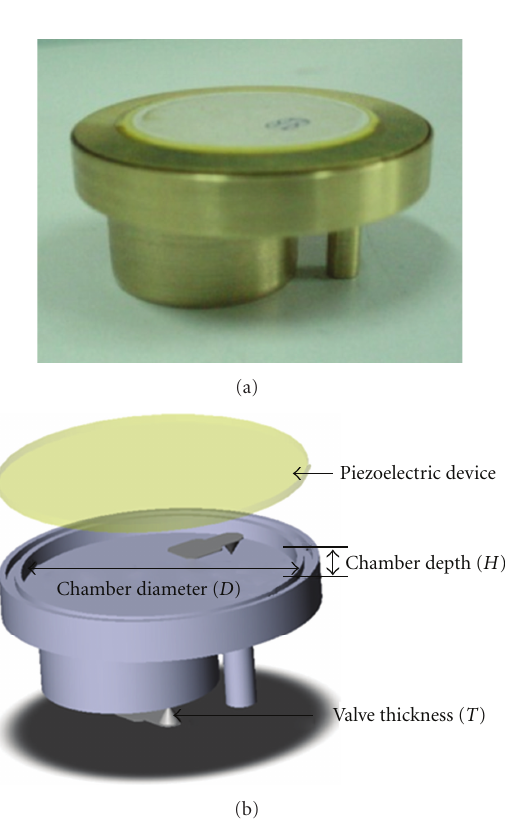
Figure 2: Assembled fuel injection system and exploded view. Table 2: The design parameters of pump